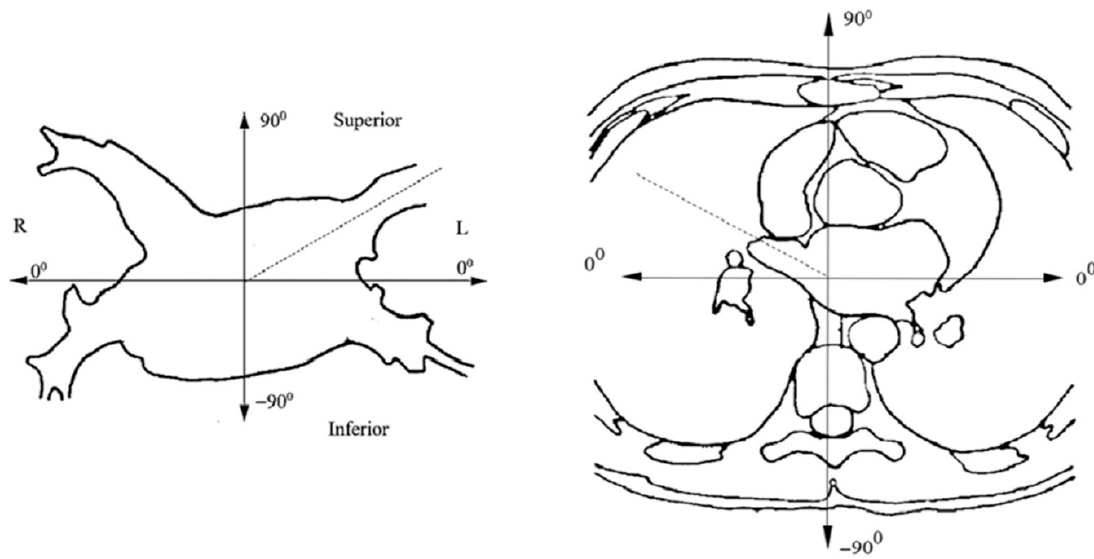
Figure 1. Coordinate system for assessing the PV spatial orientation and the LA posterior wall in the frontal and axial planes.